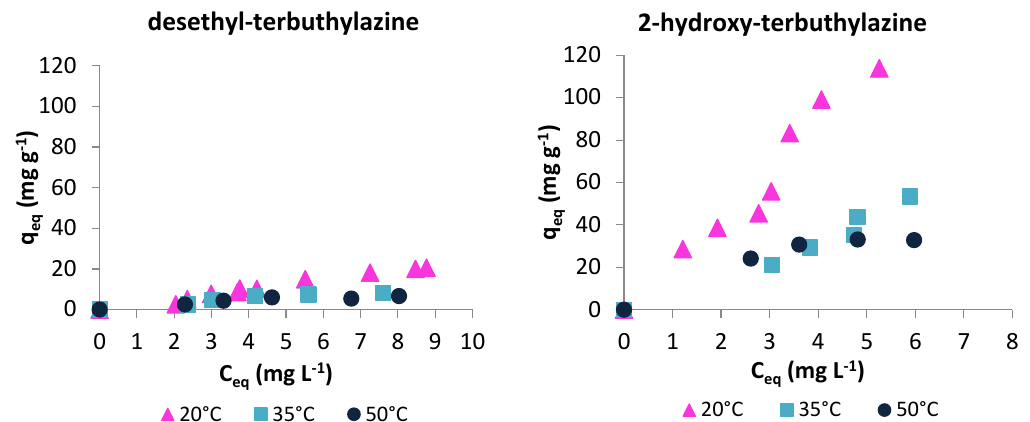
Figure 4. Adsorption isotherms for desethyl-terbuthylazine and 2-hydroxy-terbuthylazine at different temperatures: 20 °C, 35 °C and 50 °C.